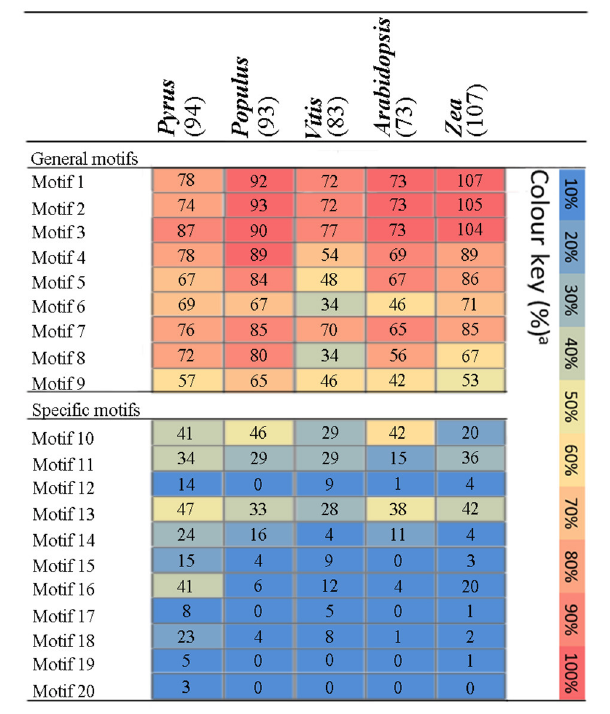
pear alignments of each motif ( Table S3 ). The matching motifs were identified from the PRX pronteins of Populus (Ren et